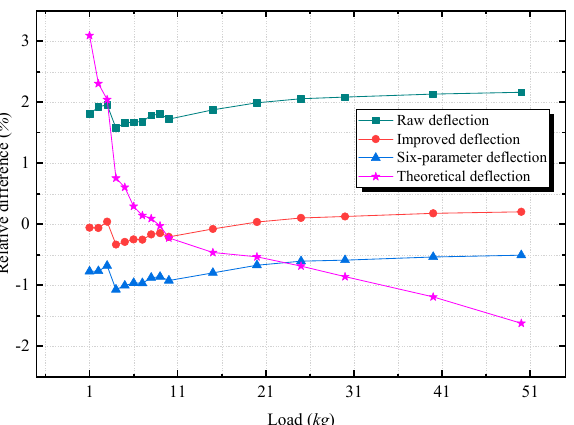
Figure 16. The relative differences of the raw deflection, the improved deflection, the six-parameter deflection, and the theoretical deflection from the reference deflection. The relative difference is equal to (value measured be different methods – reference deflection)/ reference deflection.